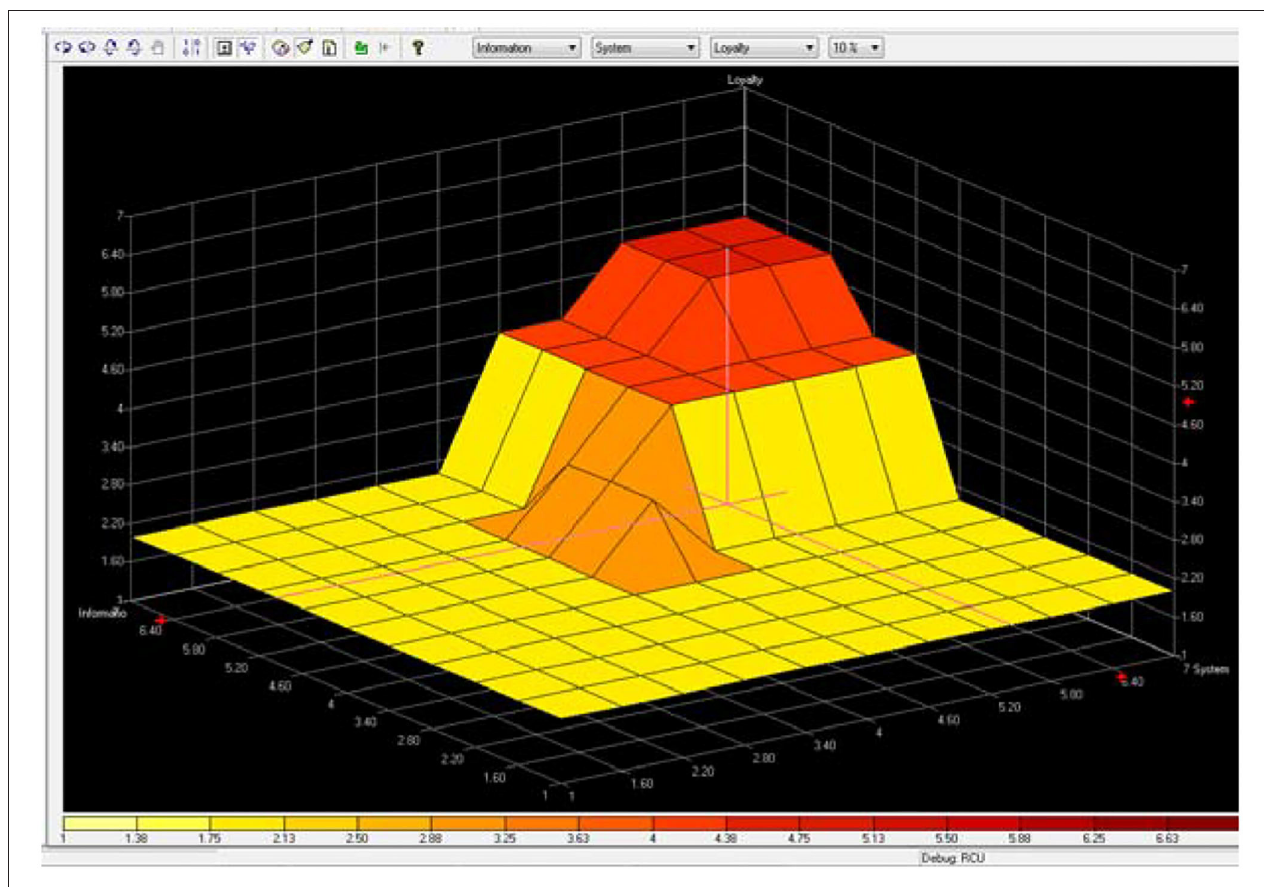
FIGURE 8 | Loyalty is positively to system and